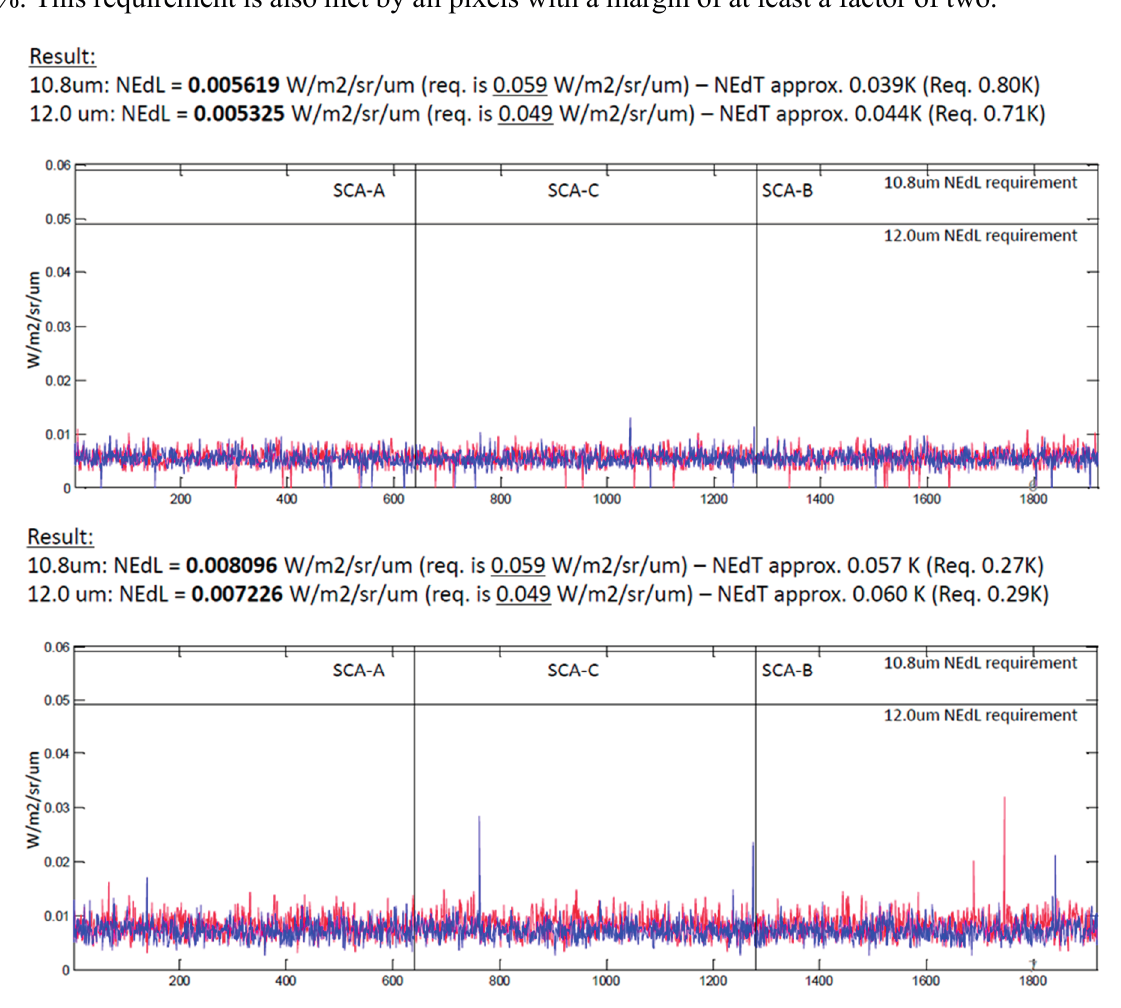
Figure 9. Noise performance in terms of NEdL and NEdT (noise equivalent temperature change) for the science pixels at 240 K ( top ) and 360 K ( bottom ) measured during thermal vacuum testing. Similar results were found for all flood source temperatures and at all instrument temperature